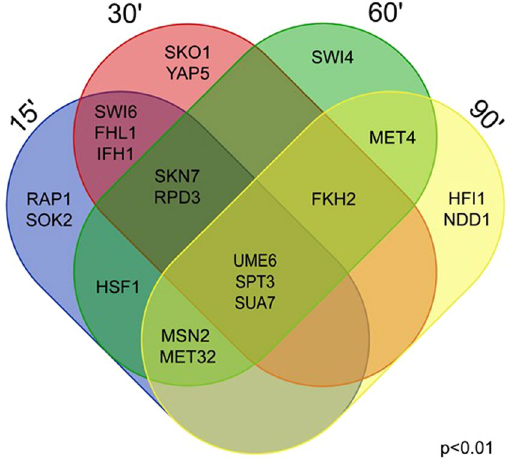
Figure 6. Venn diagram on transcription factors which show significant enrichments among the genes they regulate at the studied time-points (pval < 0.01). Enriched transcription factors are detected by using gene set